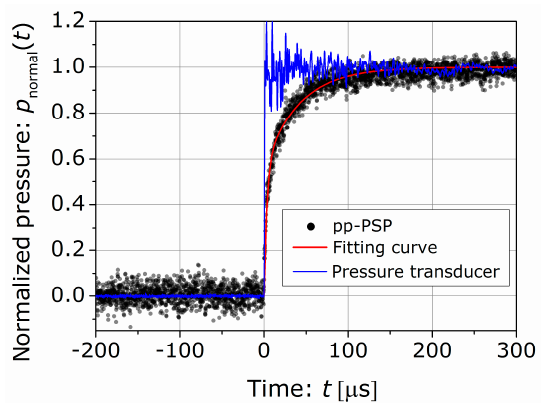
Figure 4. Time response test for pp-PSP.